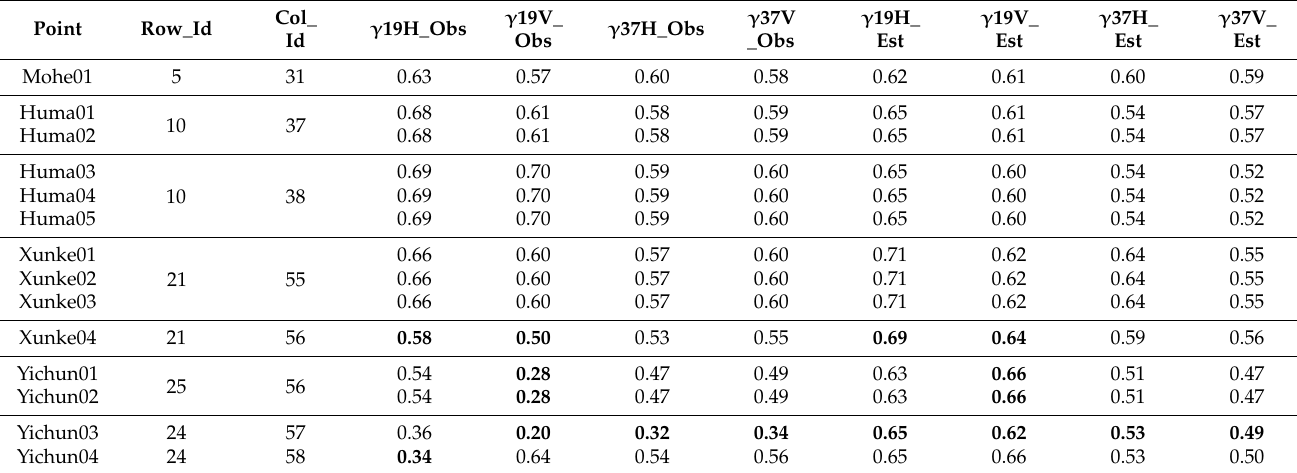
Table 2. Comparison results of measured transmissivity and transmissivity estimated by Pixel-wise transmissivity